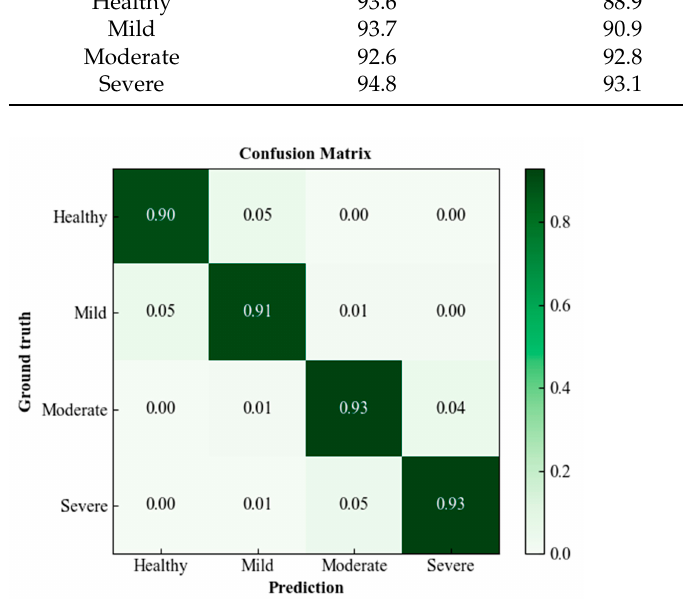
Table 6. Results of precision, sensitivity, and F 1-score for four grades.